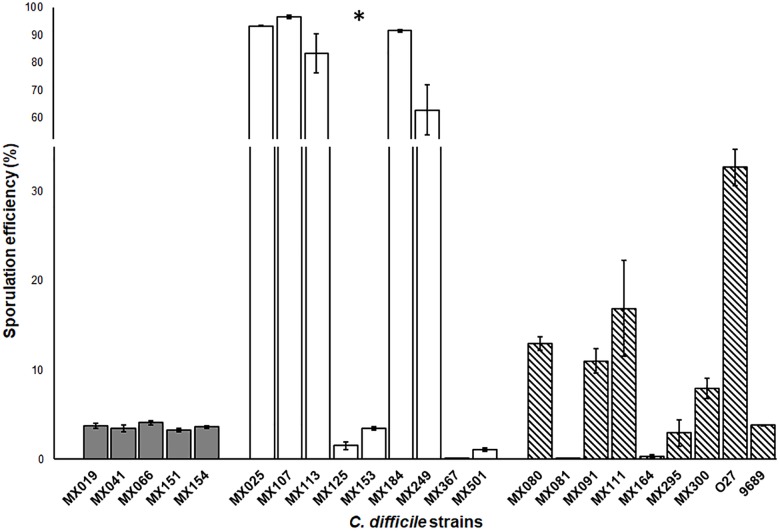
Sporulation efficiency of non-toxigenic Clostridioides difficile strains. Sporulation efficiency by chemical shock with 80% ethanol. Gray bars: cdtB+tcdA+tcdB+ strains. White bars: cdtB−tcdA−tcdB− strains. Striped bars: control toxigenic strains. Values represent the average ± standard deviation (SD) from three independent experiments. ∗p < 0.05.